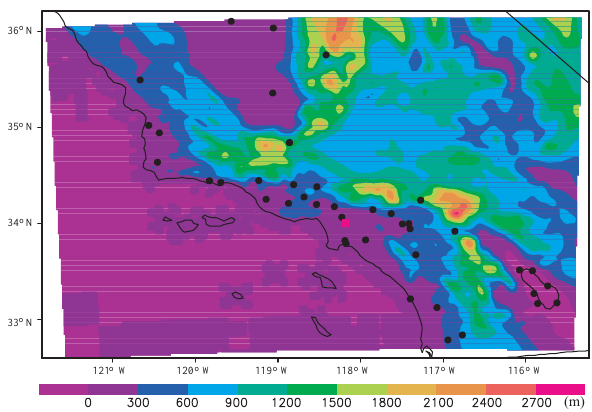
Figure 7. The topography of the innermost domain and the loca- tions of surface monitoring stations (black dots). The red square is the location of Los